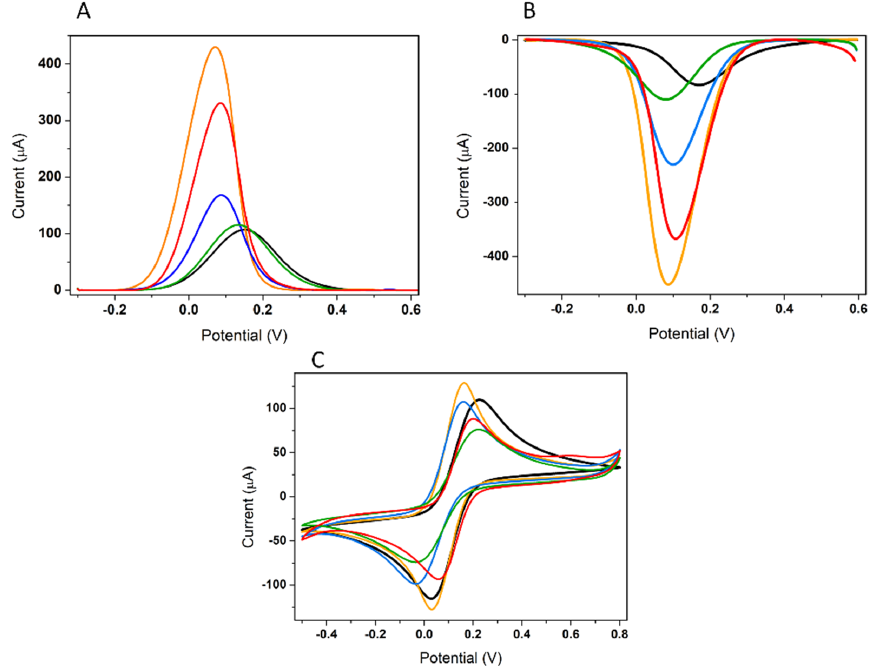
Figure 7. Electrochemical characterization of the electrode surface by DPV (oxidation) ( A ), DPV (re- duction) ( B ), and CV after each modification step in 5 mM [Fe(CN) 6 ] 3 − /4 − ( C ): bare electrode (black) ; C-SPE/AuNPs ( orange ); C-SPE/AuNPs/APT ( blue ); C-SPE/AuNPs/APT/MCH ( green ); and after incubation with 50 µ M 3-O-C 12 -HSL, for 30 min ( red ). Experimental conditions for DPV: SR of 0.01 V s − 1 , PH of 0.1 V, and a PW of 25 ms; and for CV: SR of 0.05 V s − 1 and SP of 0.00244 V.